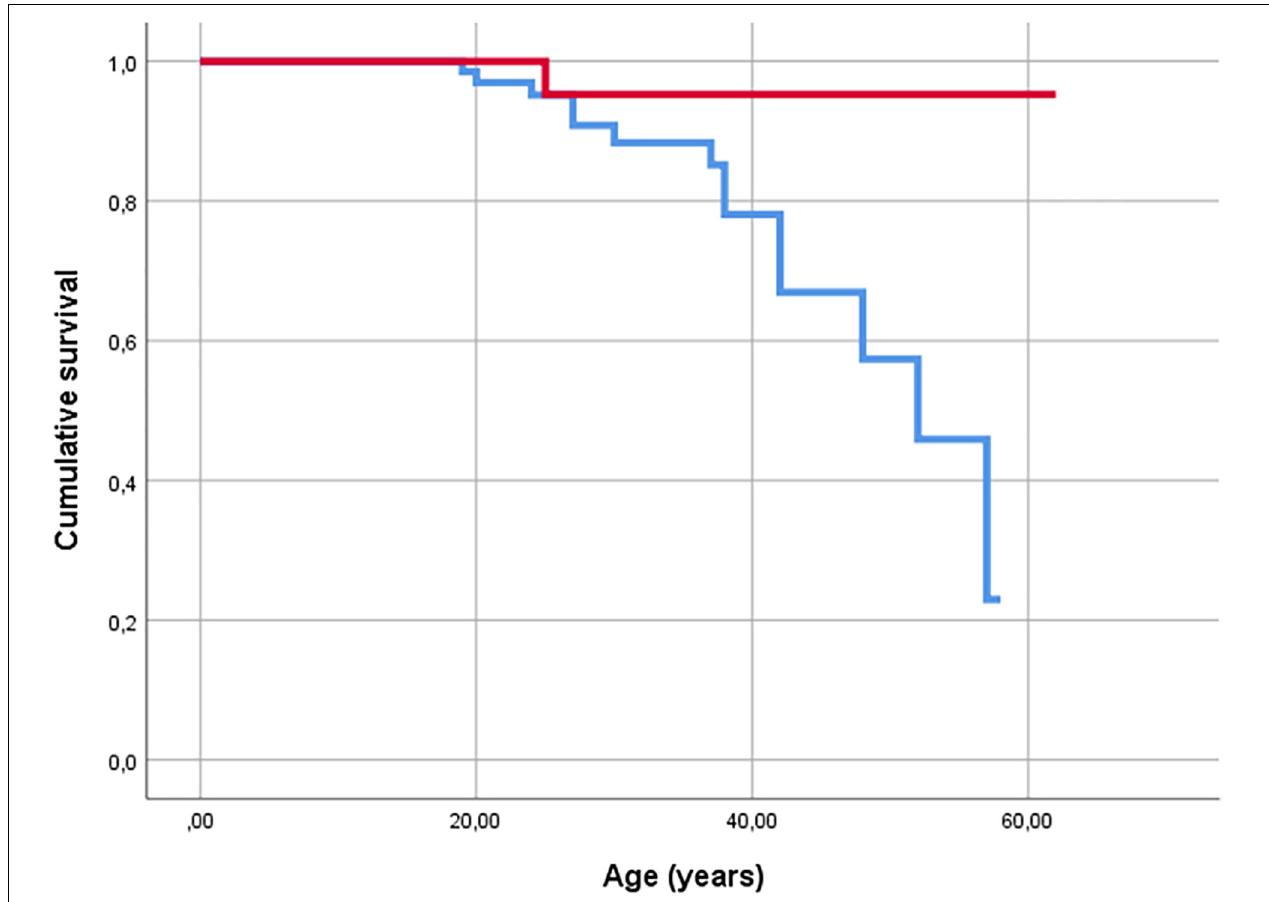
FIGURE 1 | Kaplan-Meier plot of survival of CF patients. Events are defined as death ( n = 13) and lung transplantation ( n = 2) (end stage CF). Red line indicates carriers of A allele, and blue line indicates G/G homozygous patients.